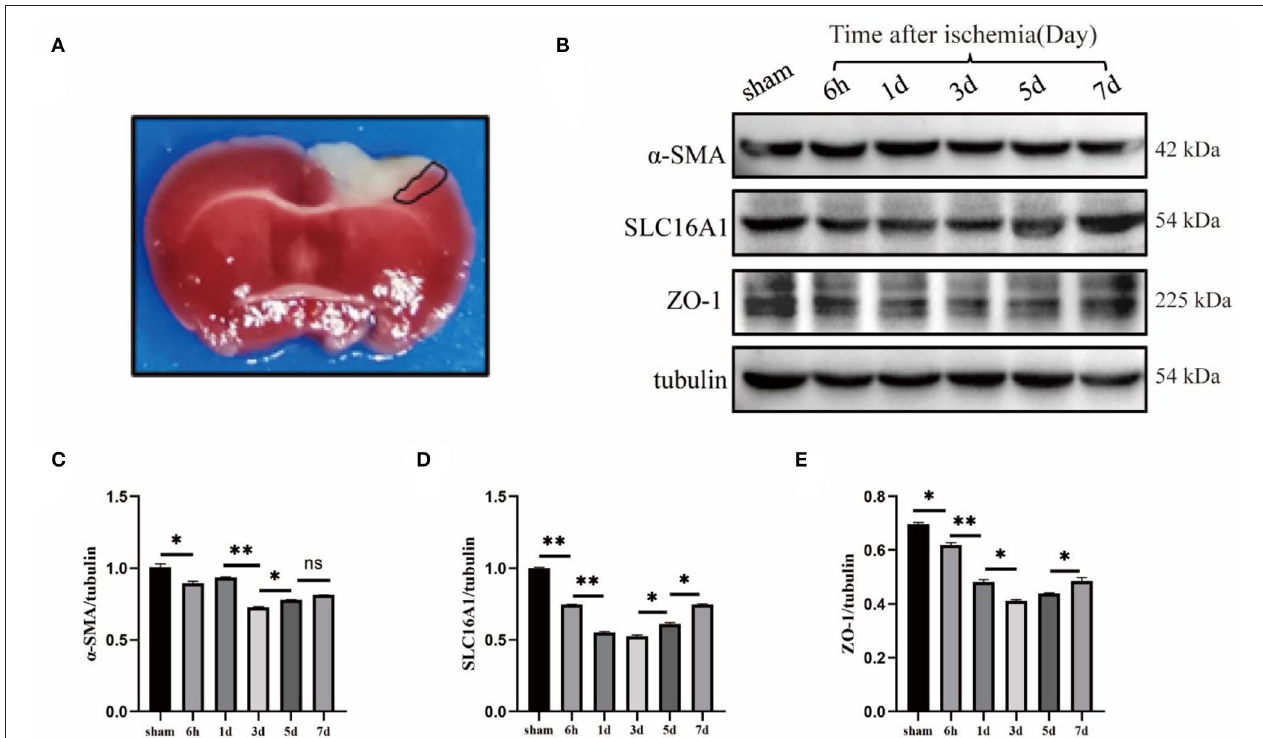
FIGURE 1 | Changes of cerebrovascular Sertoli cell, endothelial cell, and blood-brain barrier tight junction protein after photothrombotic stroke. (A) TTC staining image of cerebral ischemia model induced by photothrombosis. The white area of cortex is the cerebral infarction area, and the area surrounded by the black lines is the ischemic penumbra area (i.e., the junction between ischemic necrotic tissue and normal tissue), which is usually used for Western blot (WB) experiment of brain tissue in this area. (B) Wildtype mice were used to do sham, 6-h, 1-day, 3-day, 5-day, and 7-day time points of cerebral ischemia model, WB. (C–E) The statistical results showed that α -SMA (smooth muscle actin), SLC16A1 (venous-capillary marker) and ZO-1 (Zonula Occludens-1) were all significantly reduced in expression on day 3, which was statistically significant. n = 3 in all the experimental groups. Data are represented as mean with SEM. * p < 0.05, ** p < 0.01. α -SMA, smooth muscle actin; SLC16A1, solute carrier family 16 member 1 recombinant protein; ZO-1, Zonula Occludens-1.